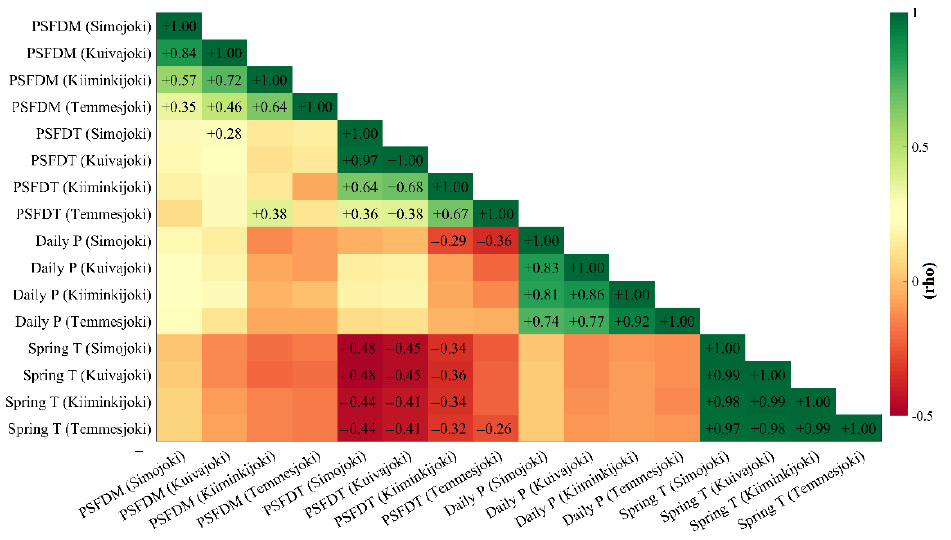
Figure 8. The Spearman’s rank correlations (rho) among peak spring flood discharge magnitude (PSFDM). PSFD timing (PSFDT), PSFDT’s corresponding daily precipitation (Daily P), and springtime Tmean in all the Simojoki, Kuivajoki, Kiiminkijoki, and Temmesjoki rivers across northern Finland during 1967–2011. The given rho values are statistically significant ( p <